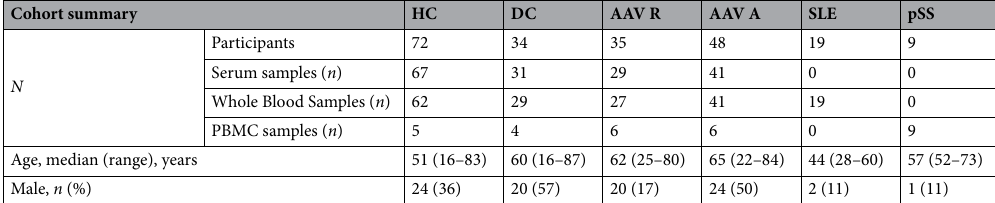
Table 1. Cohort summary: All participants have been categorised as either Healthy controls (HC), Disease controls (DC), AAV patients (Active {A} or Remission{R}), Systemic Lupus Erythematosus (SLE) or primary Sjogren’s syndrome (pSS). A summary of the samples obtained as well as the median age and sex breakdown is shown. Age and sex breakdown for the HC cohort is based off of whole blood and serum donors only (n = 67) as this data was unavailable for participants involved in PBMC analysis (n =